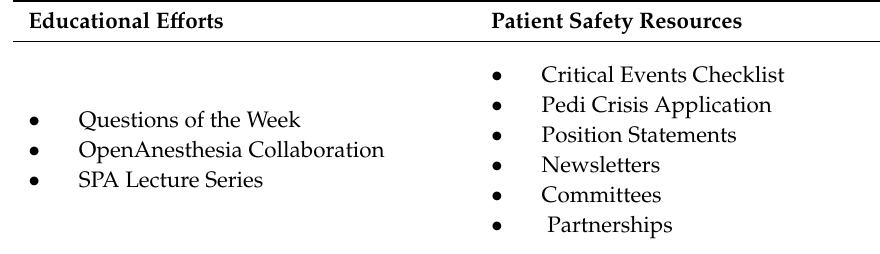
Table 2. Society for Pediatric Anesthesia (SPA) educational e ff orts and patient safety resources.